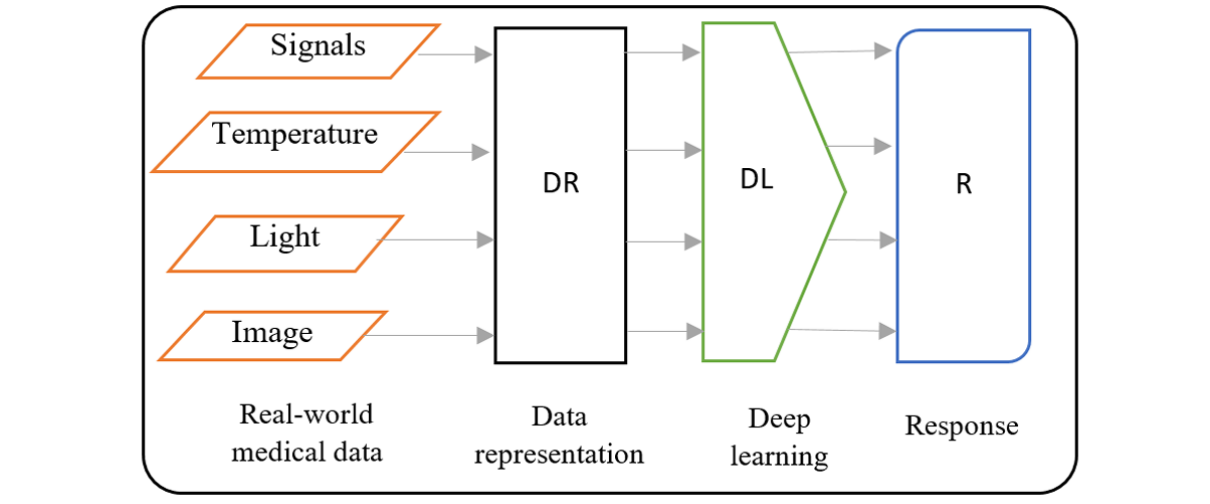
Figure 16. Expected required technique in biomedical application of deep